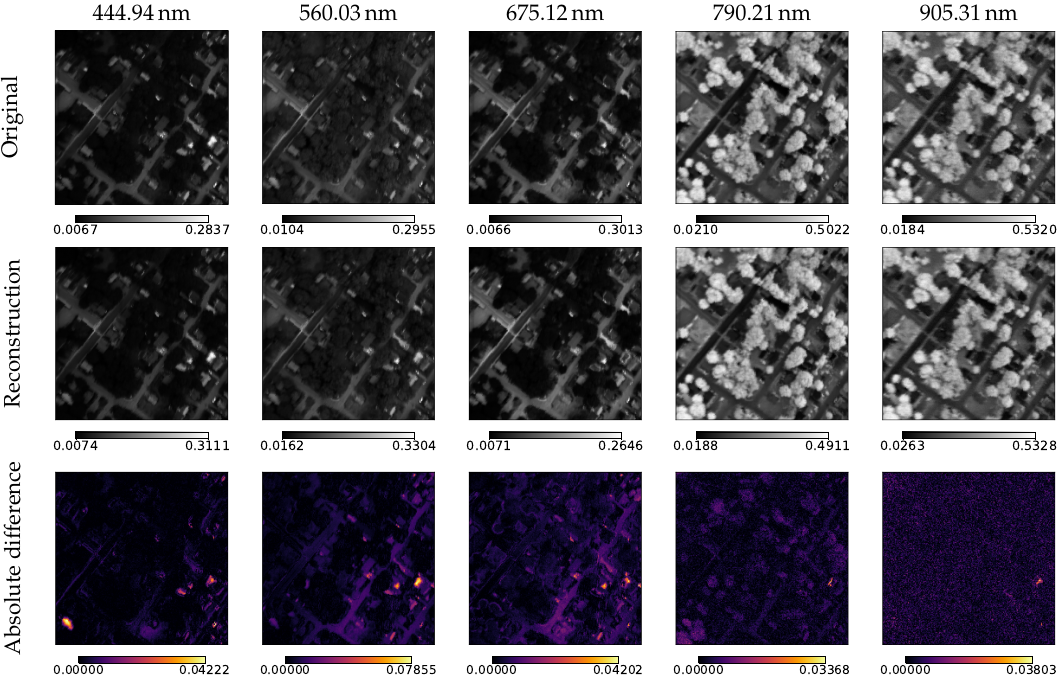
Figure 8. Examples of reconstructed bands for a portion of test imagery predicted using model with 4 free bands trained on Aerial images